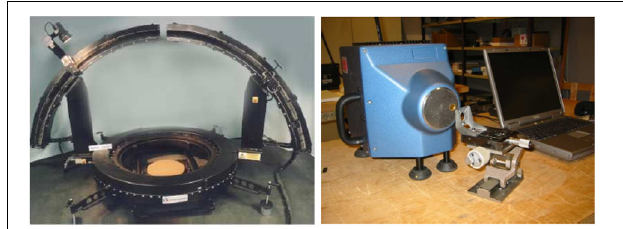
FIGURE 2 | Left: Goniometer used for albedo measurements. Right: Instrument used for emissivity measurements.